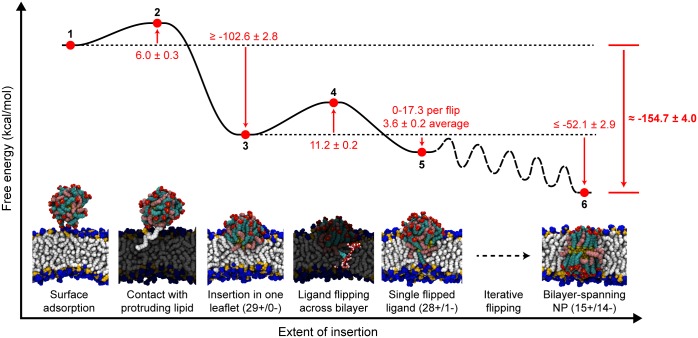
Energy landscape and simulation snapshots of representative configurations along the bilayer insertion pathway.All labeled values are reported in kcal/mol and the energy landscape is not drawn to scale We further note that the landscape is estimated subject to the assumptions discussed in the text. The free energy landscape does not include all possible ligand distributions which would be observed between states 5 and 6; the path between these states is labeled as “iterative flipping” to refer to the intermediate transitions between missing ligand distributions. The total free energy change between the initial (1) and final (6) states is highlighted in bold.